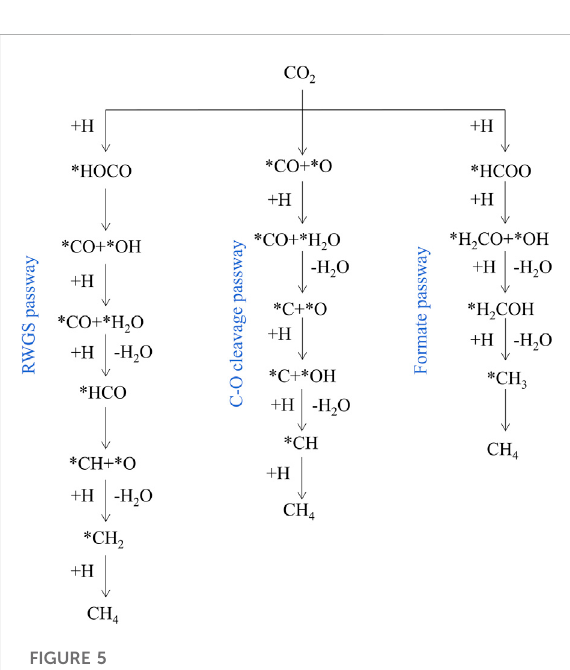
FIGURE 5 Simpli fi ed CO 2 methanation reaction